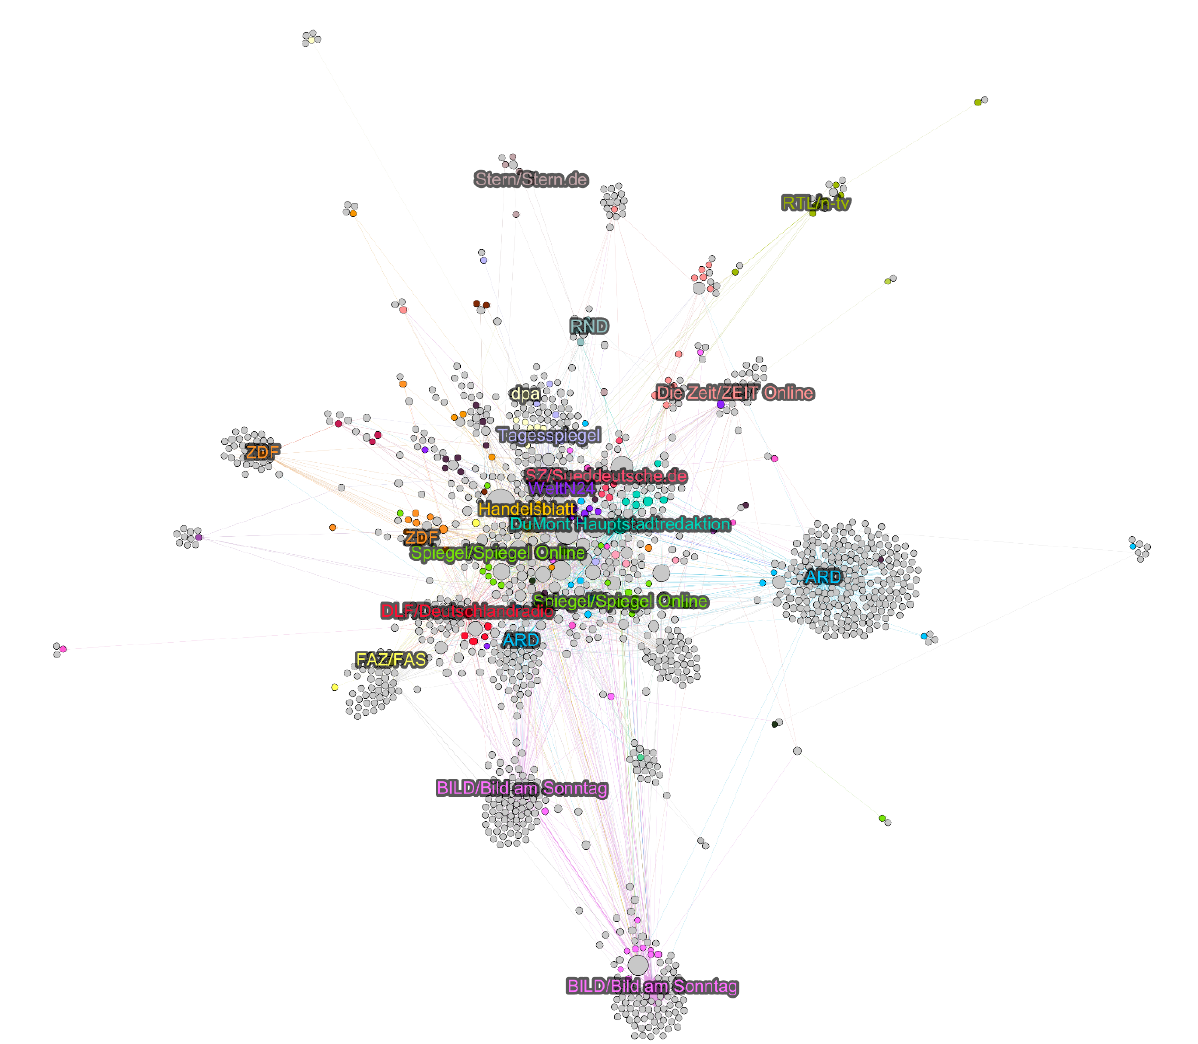
Figure 1. Bundespressekonferenz @mention network for accounts with degree > 9 (2017). Network diameter: 9 (average geodesic distance: 4.147). Network density: 0.001 2